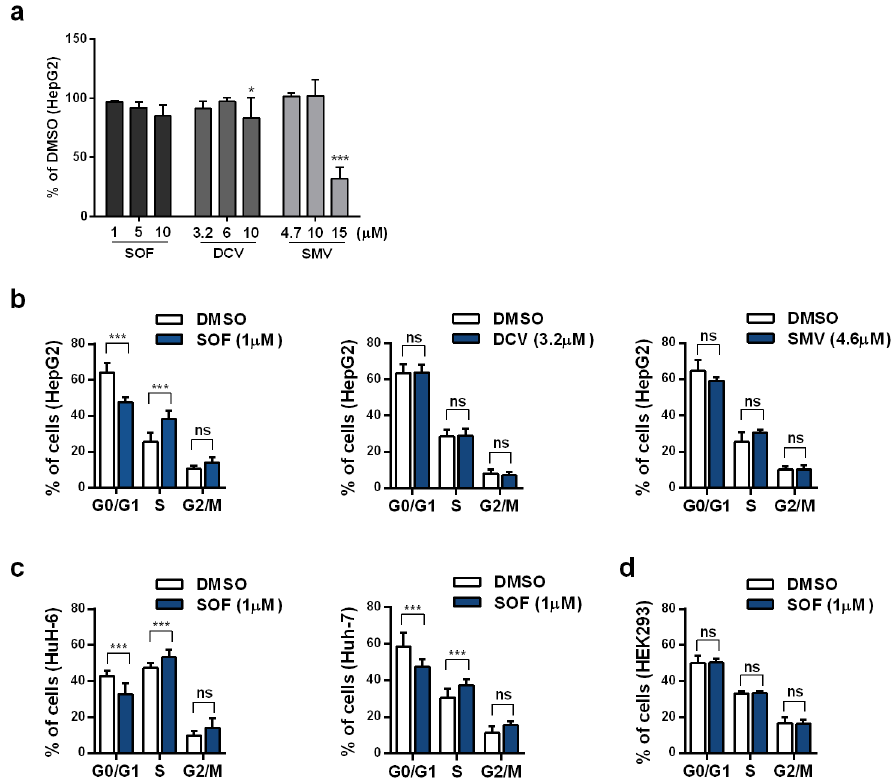
Figure 1. Cell cycle distribution after DAA treatment. ( a ) Cytotoxicity of an increasing concentration of each DAA in HepG2 cells was detected by Rotitest ® Vital. Bar graph displays the absorbance as a fold change in relation to DMSO. Cell cycle distribution was evaluated by flow cytometric analysis of DNA content in HepG2 cells treated with SOF, DCV, or SMV ( b ); HuH-6 and Huh-7 cells ( c ); and HEK293 cells ( d ) treated with SOF for four consecutive days. Data are displayed as the percentage of cells in each phase. All shown data represent mean + s.d. from three independent experiments. Statistical significance was determined through two-way ANOVA ( a – d ). ns: not significant; * p ≤ 0.05; *** p ≤ 0.005.